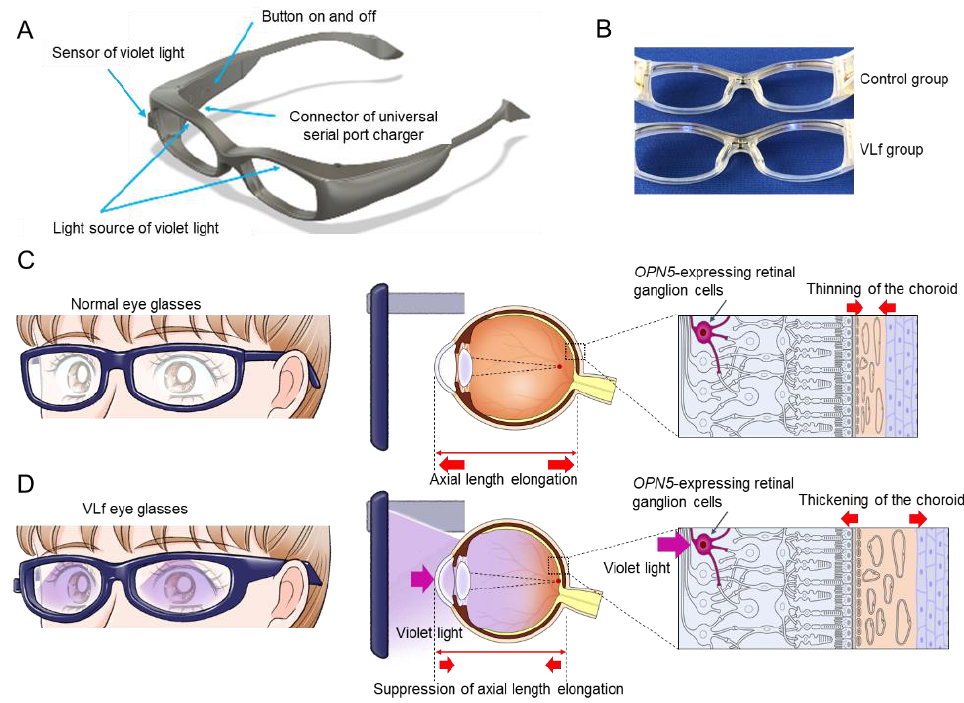
Figure 1. The schema and mechanism of the VLf that emits violet light (VL). The pseudo-placebo (control) and VLf ( A ). The control eyeglasses emit a minimal irradiance of VL under 10 µ W/cm 2 (control group, top of B ) and VLf emit VL irradiance of 310 µ W/cm 2 (VLf group, bottom of B ). In the myopic patients with normal eyeglasses, the axial length is elongated with choroidal thinning ( C ). In the myopic patients with VLf, the axial length elongation is suppressed with choroidal thickening, presumably through OPN5-expressing retinal ganglion cells by emitting VL from the VLf frames, as was demonstrated in the mouse experience ( D ). VLf: violet light eyeglasses frames.